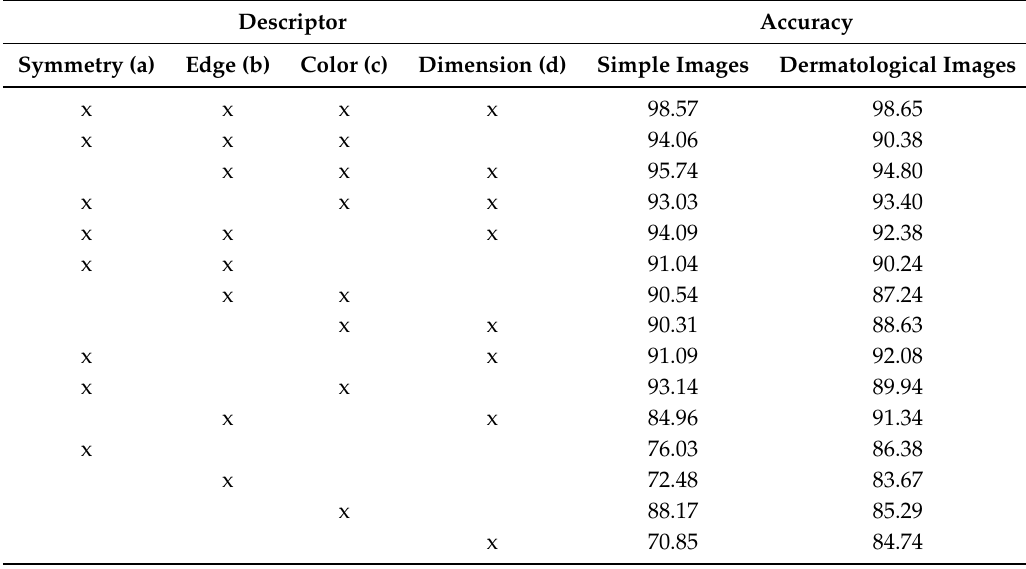
Table 3. Accuracy obtained with different descriptors